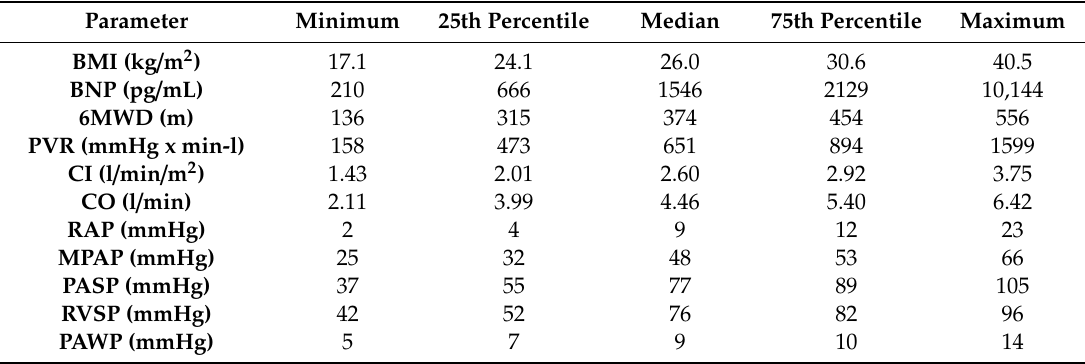
Table 2. IPAH patient characteristics. Haemodynamic parameters, as well as BMI and levels of BNP of 25 IPAH patients are presented with the medians, minima, maxima, and 25th and 75th